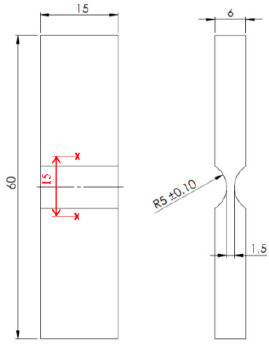
Figure 6. Drawing of plane strain test specimen.